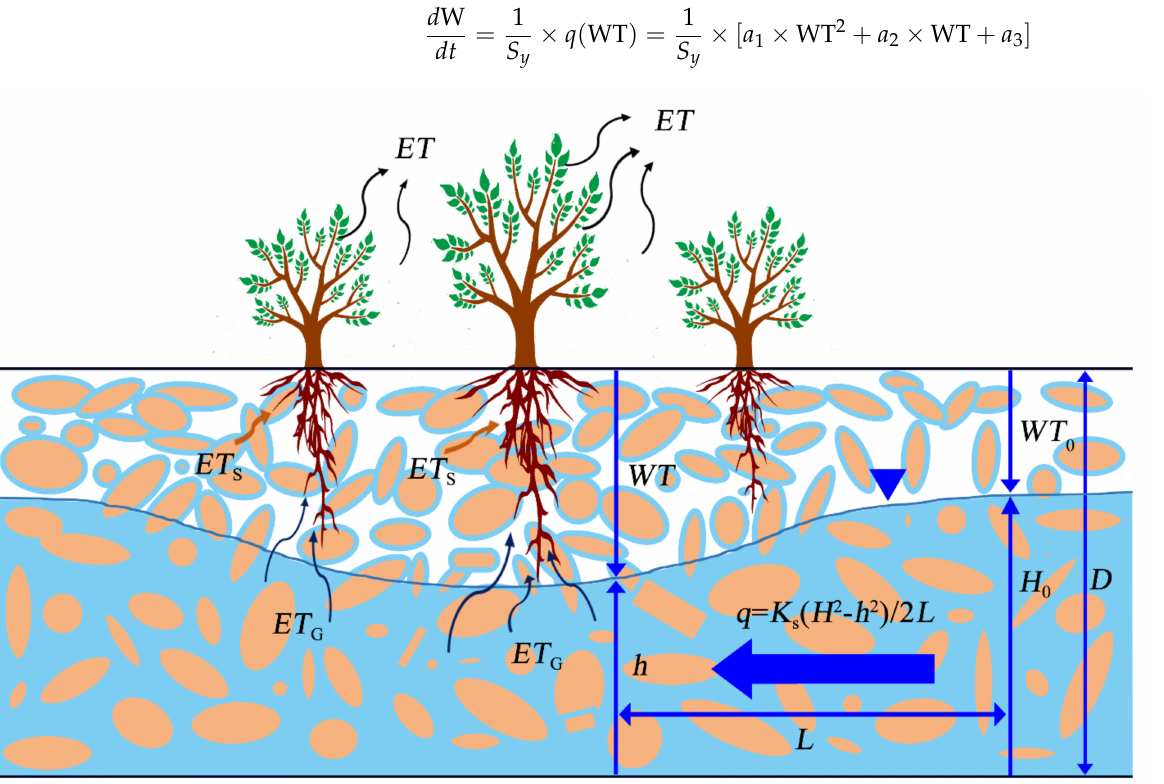
Figure 2. Conceptual diagram showing groundwater flow toward a riparian zone where it discharges via root uptake by phreato-phytic vegetation. ET s: ET from soil water [L T − 1 ]; ET G : ET from groundwater [L T − 1 ]; WT 0 and WT: water table depth in the background and the riparian zone [L], respectively; h 0 and h : the groundwater elevation in the background and the riparian zone [L], respectively; D : the total depth of the aquifer [L]; L : the distance from the background to the riparian zone [L]; and q : the groundwater flow rate toward the riparian zone [L T − 1